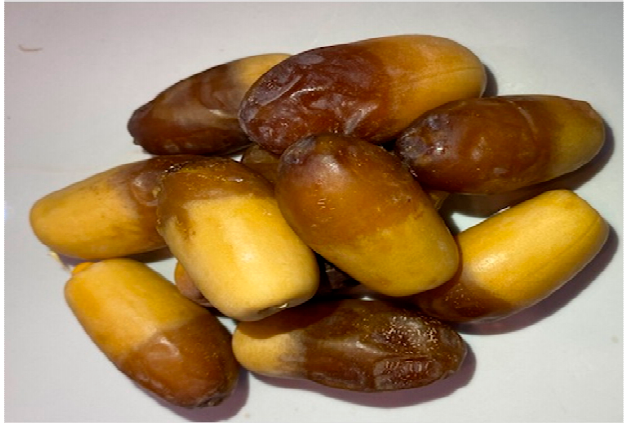
Figure 7. Sample of Al-hyza dates .